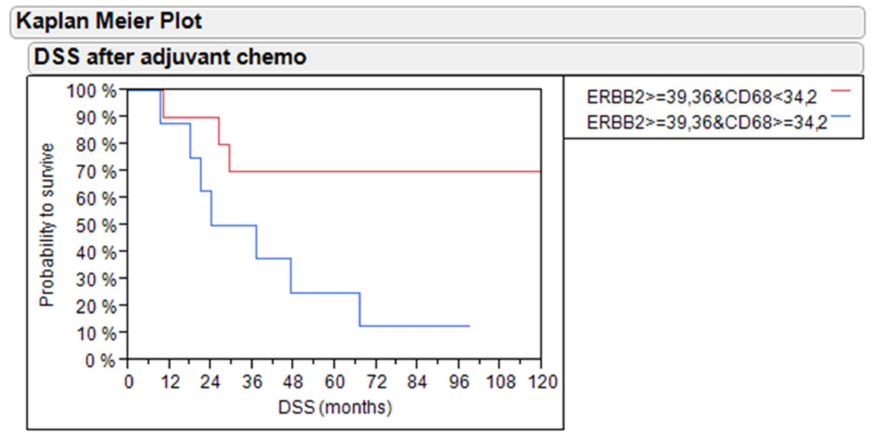
Figure 8. DSS of bladder cancer patients treated with adjuvant chemotherapy based on ERBB2 -positive tumors in relation to CD68 mRNA levels in the PCR and IHC